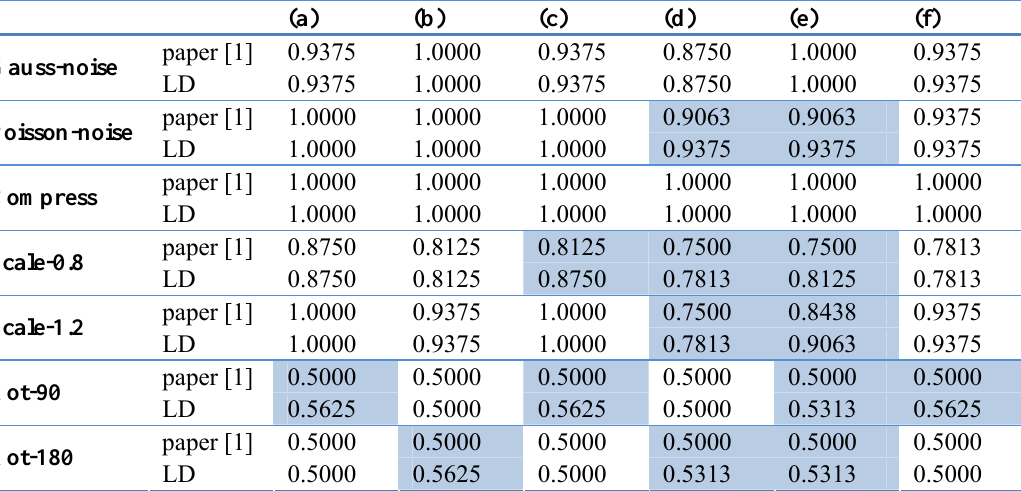
Table 3 Comparison of the Match-Degree between two